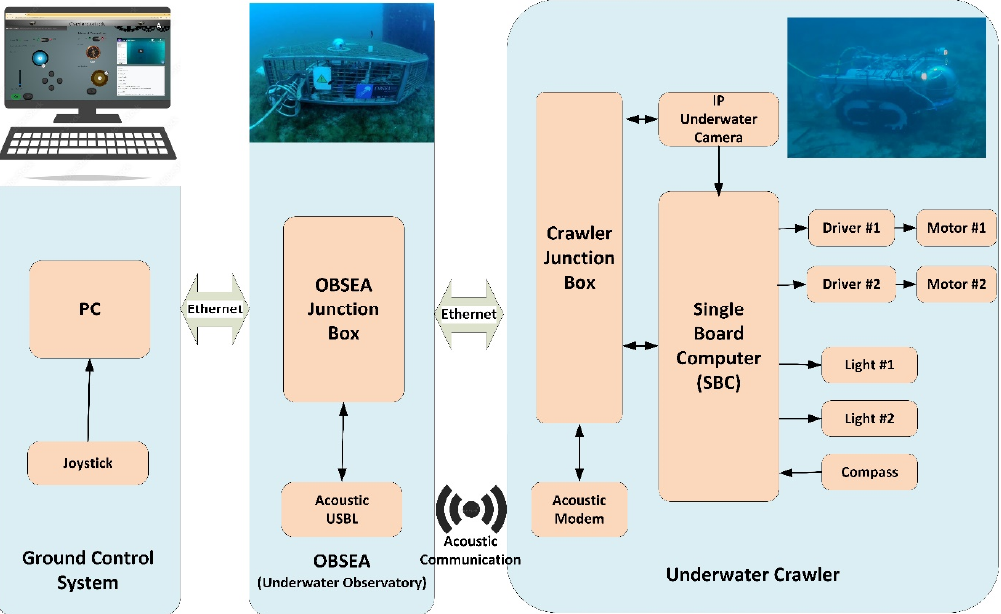
Figure 5. The web architecture for the remote control of the crawler through the OBSEA portal. Notably, the OBSEA is endowed with an acoustic USBL for wireless communications with the crawler which allows for modular control expansion in relation to future sensors.